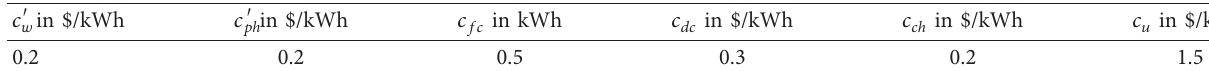
Table 3: Cost coefficients for various components of the microgrid.